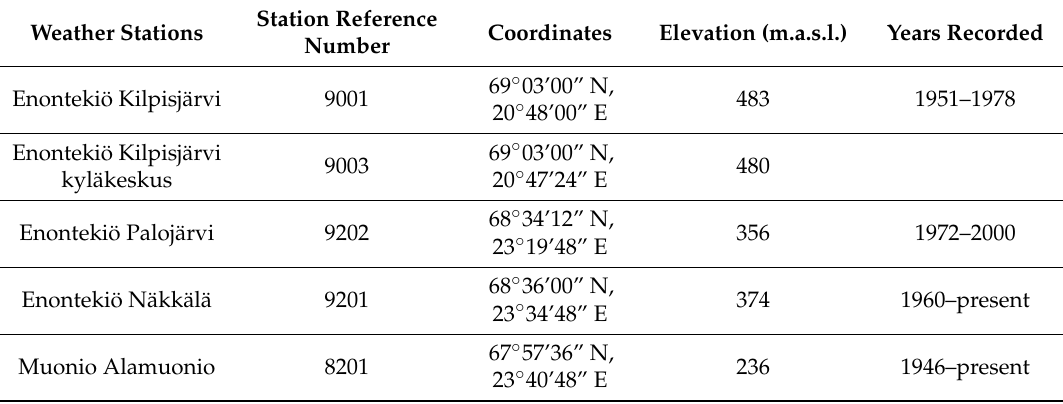
Table 1. Description of the three meteorological